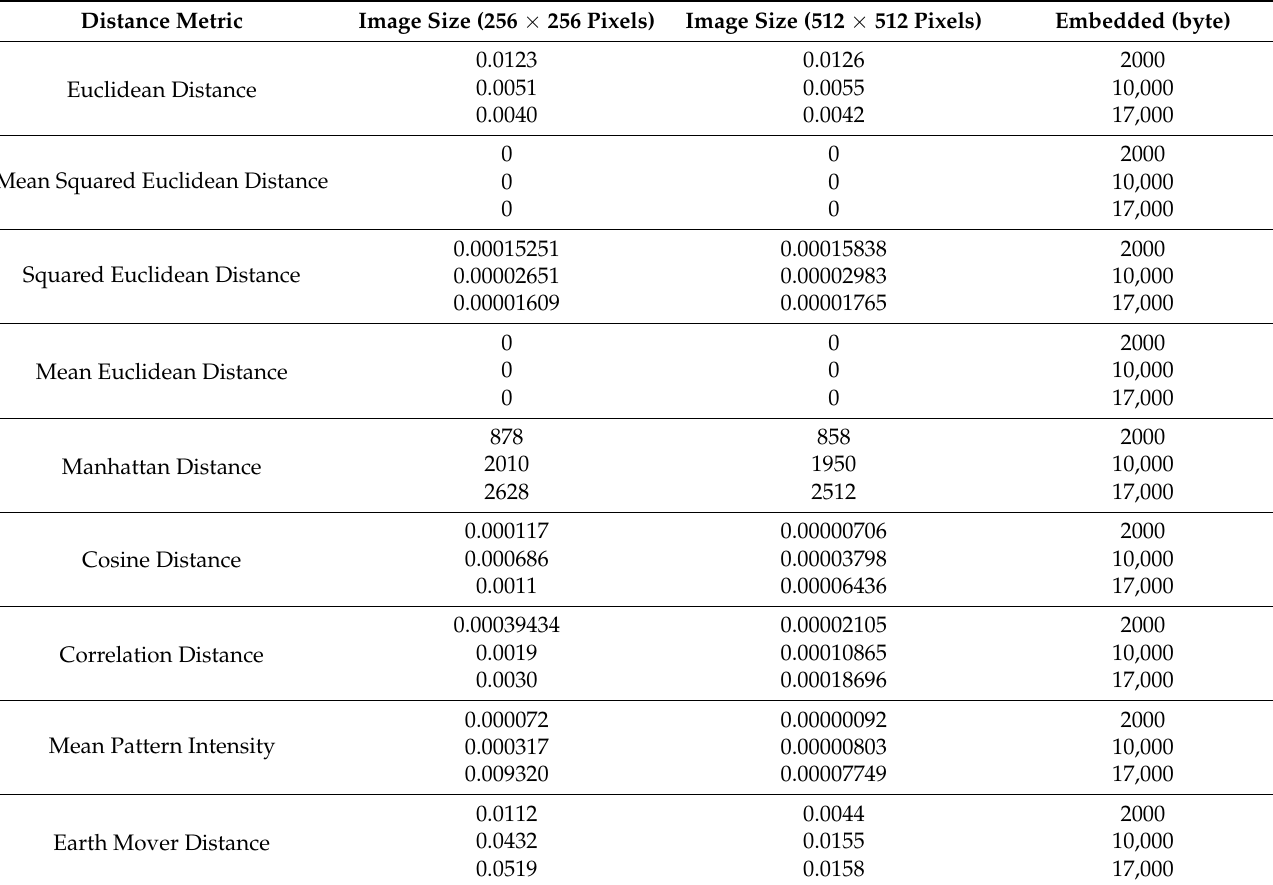
Table 7. Analysis of stego and cover images by distance using different colour image Lina